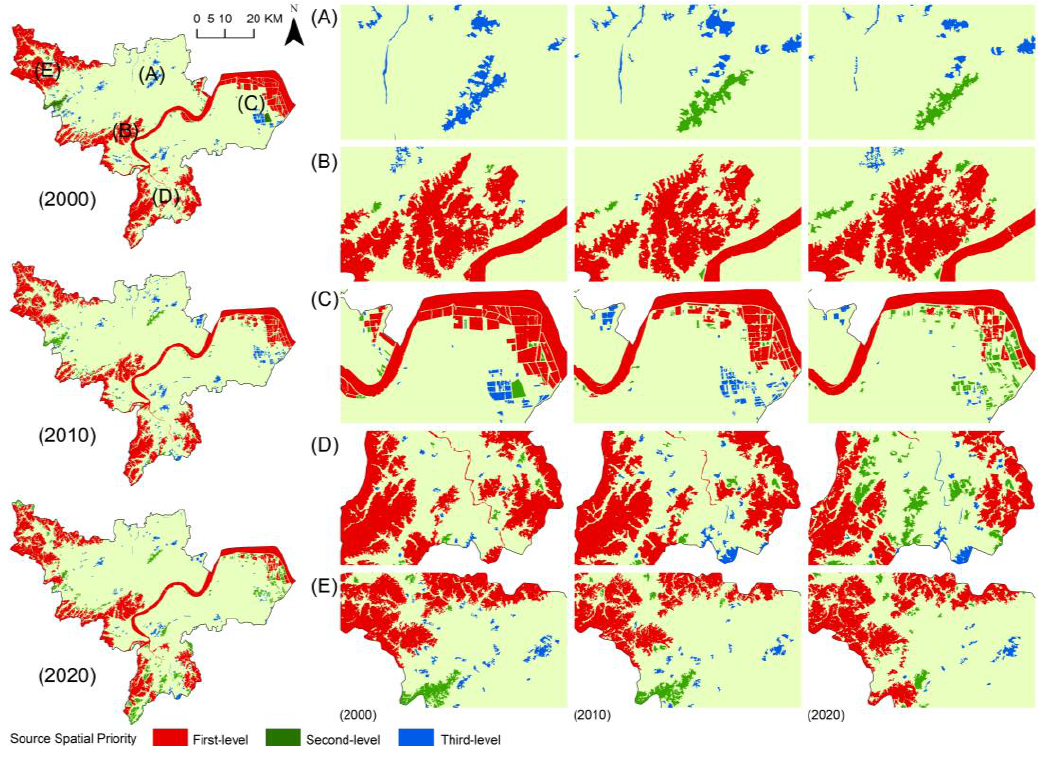
Figure 5. GI sources ’ spatial priority distribution at all levels in 2000, 2010, and 2020: ( A ) Banshan National Forest Park, ( B ) West Lake Scenic Area, ( C ) Qiantang River Wetland, ( D ) Shiniu Mountain – Qinghua Mountain Scenic Area, and ( E ) Jingshan Scenic Area. Table 3. Division and definition of the spatial prioritization of different GI elements at each